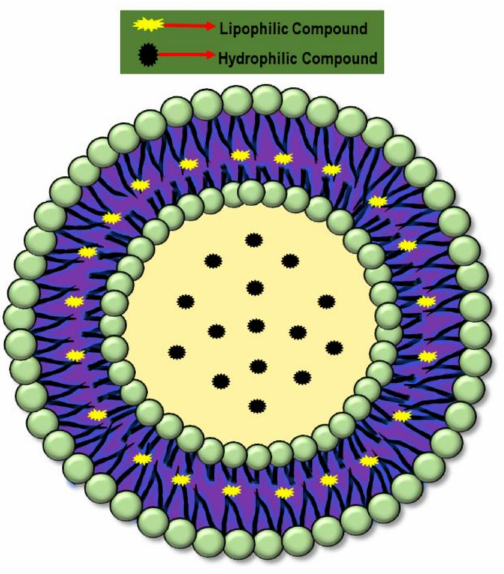
Figure 3. Lecithin-mediated liposome formation and entrapped